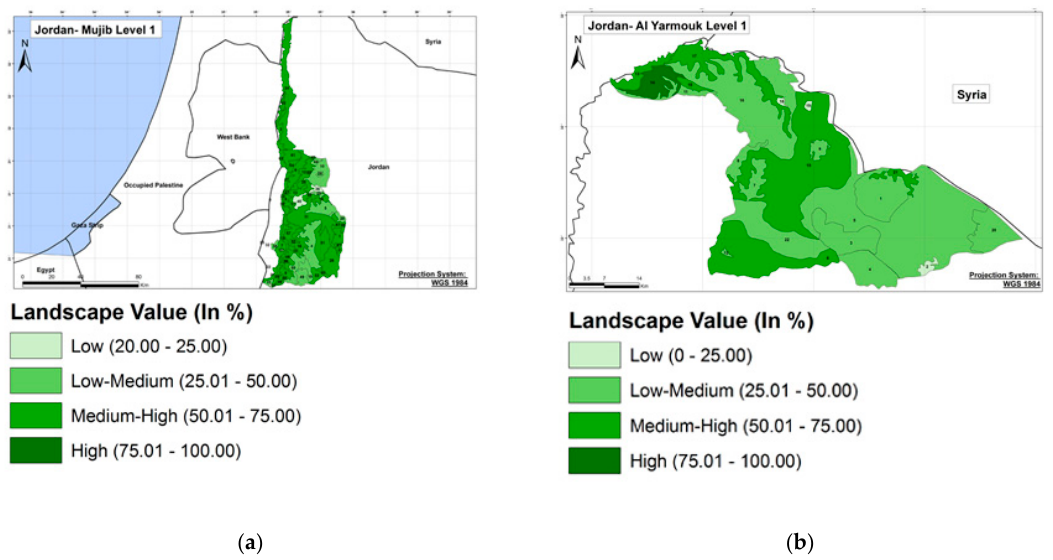
Figure 15. Landscape Value (LV) maps in Jordan: ( a ) Mujib and ( b ) Al-Yarmuk.